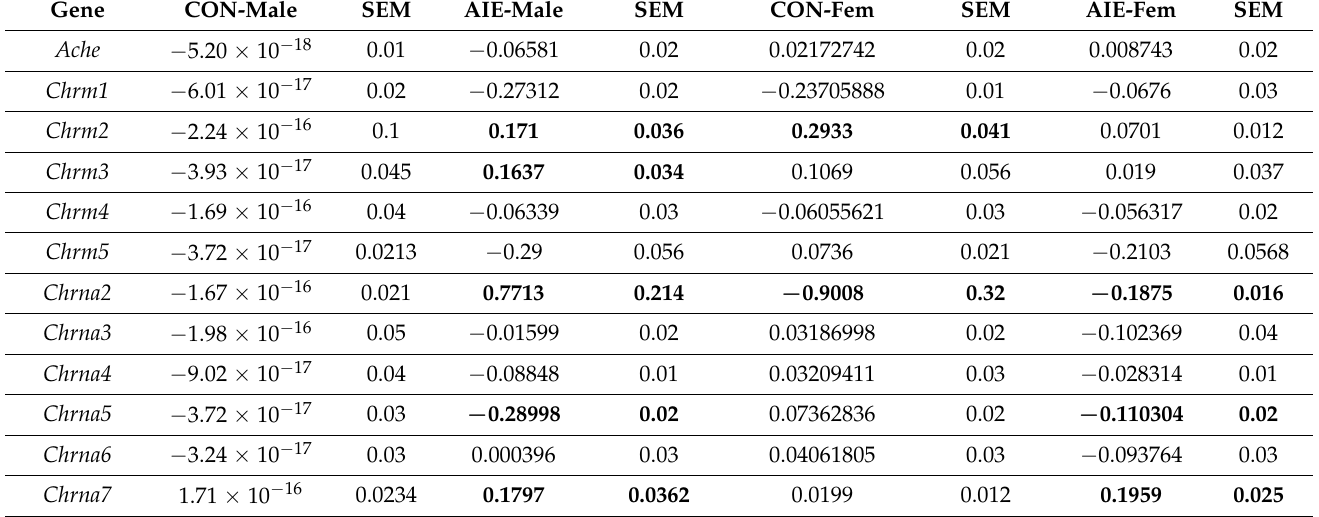
Depicts the mean ( ± SEM) change in gene expression in male and female Wistar AIE and CON rats (log 10 transformation) for all detected genes in the AcbSh. Bold indicates statistical significance (see Figures 2 and 3 for